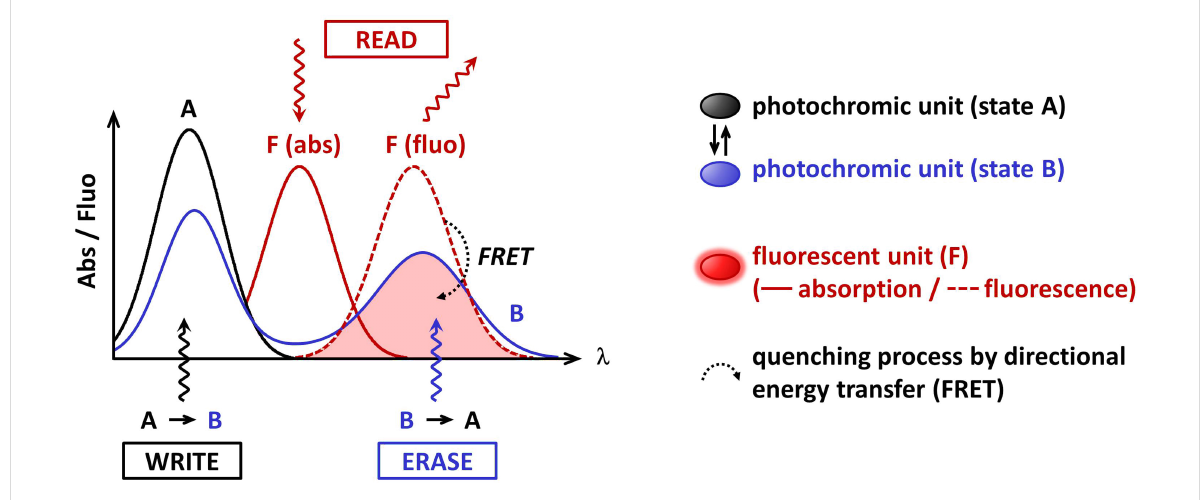
Figure 1: Requirements on absorption and emission spectral features of the photochromic and fluorescent units of the platform to induce efficient fluorescence photoswitching by energy transfer process (FRET).